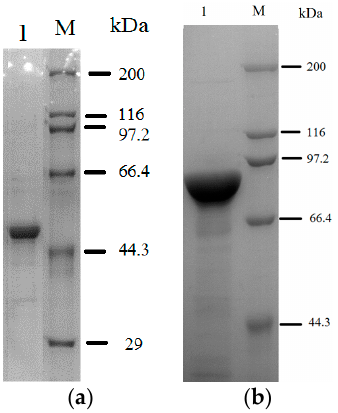
Figure 1. Analysis of purified SOD-ELP ( a ) and CAT-ELP ( b ) by sodium dodecyl sulfate polyacrylamide gel electrophoresis (SDS-PAGE). Lane M: molecular mass marker (KDa); Lane 1 is for the purified